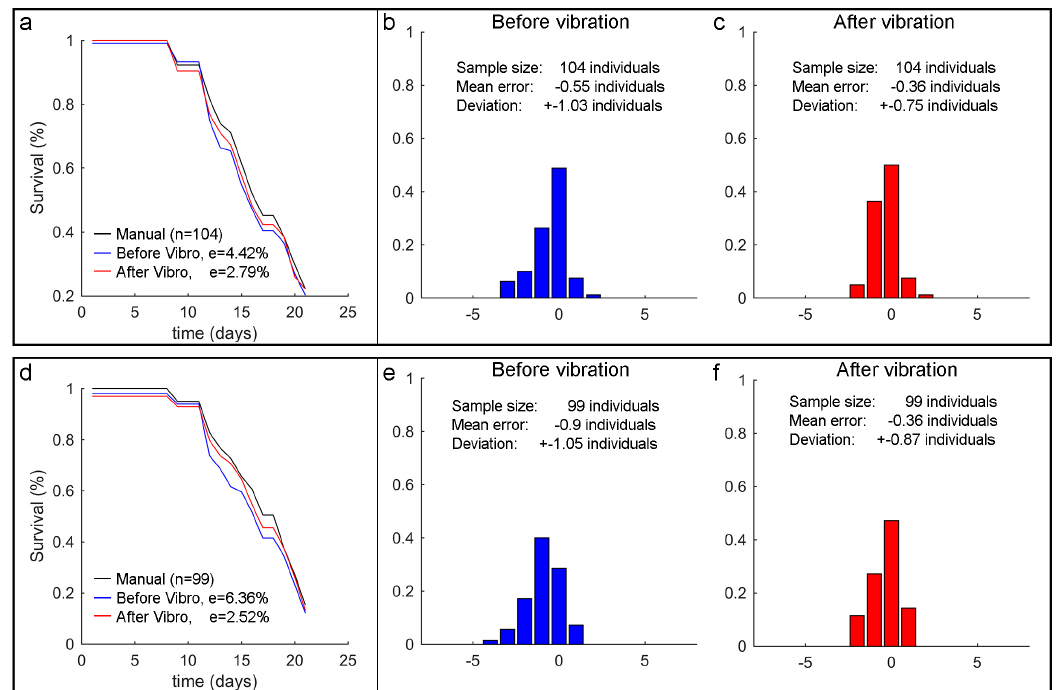
Figure 11. Lifespan results of experiment 1. ( a – c ) are the condition V d vibration from day 9). This represents an error before and after vibration. ( d – f ) are for the condition V d sample (subjected to a 5 s vibration from day